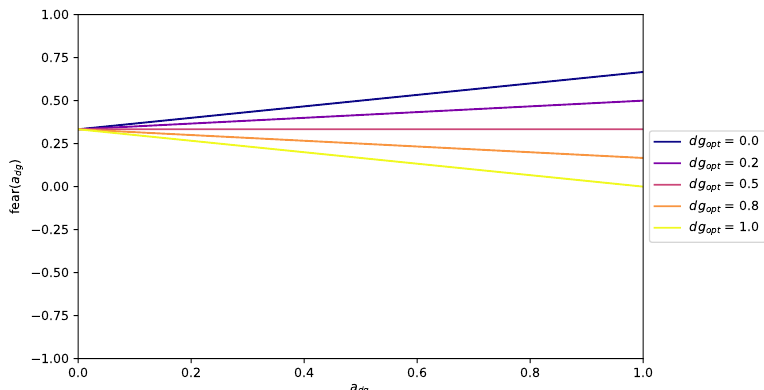
Figure 7. The progression of the fear function f ( x ) for a changing intensity of dg and different values for dg opt , where a py = a dark = 0.5 and py opt = dark opt = 0 are fixed.